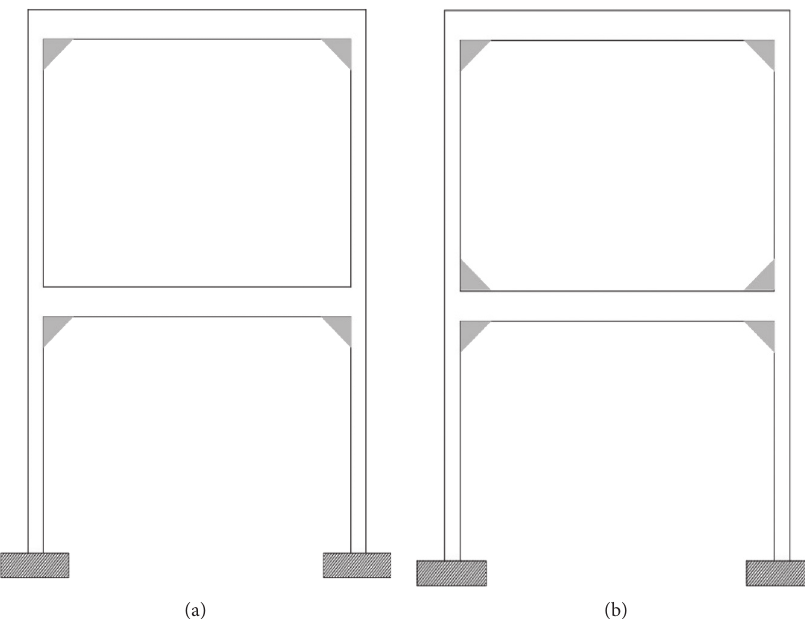
Figure 4: RC haunch retrofitting schemes considered for investigation in the research [33]. (a) Model-MRC RC haunch below beam only. (b) Model-MRC2 RC haunch both below and above beam.